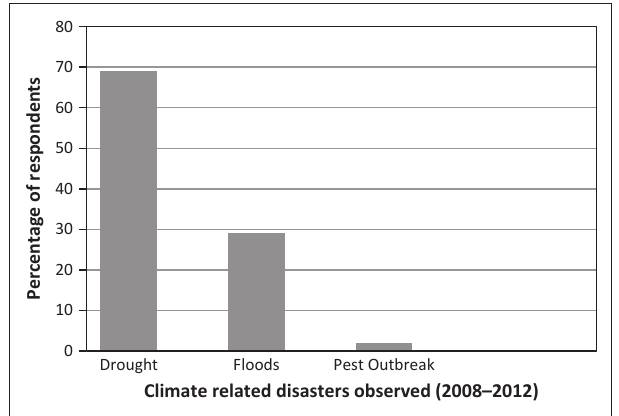
FIGURE 2: Climate related disasters observed in North-Central Namibia (2008–2012). TABLE 4: Intensity of drought and floods experienced during the period between 2008 and 2012. Climate risk